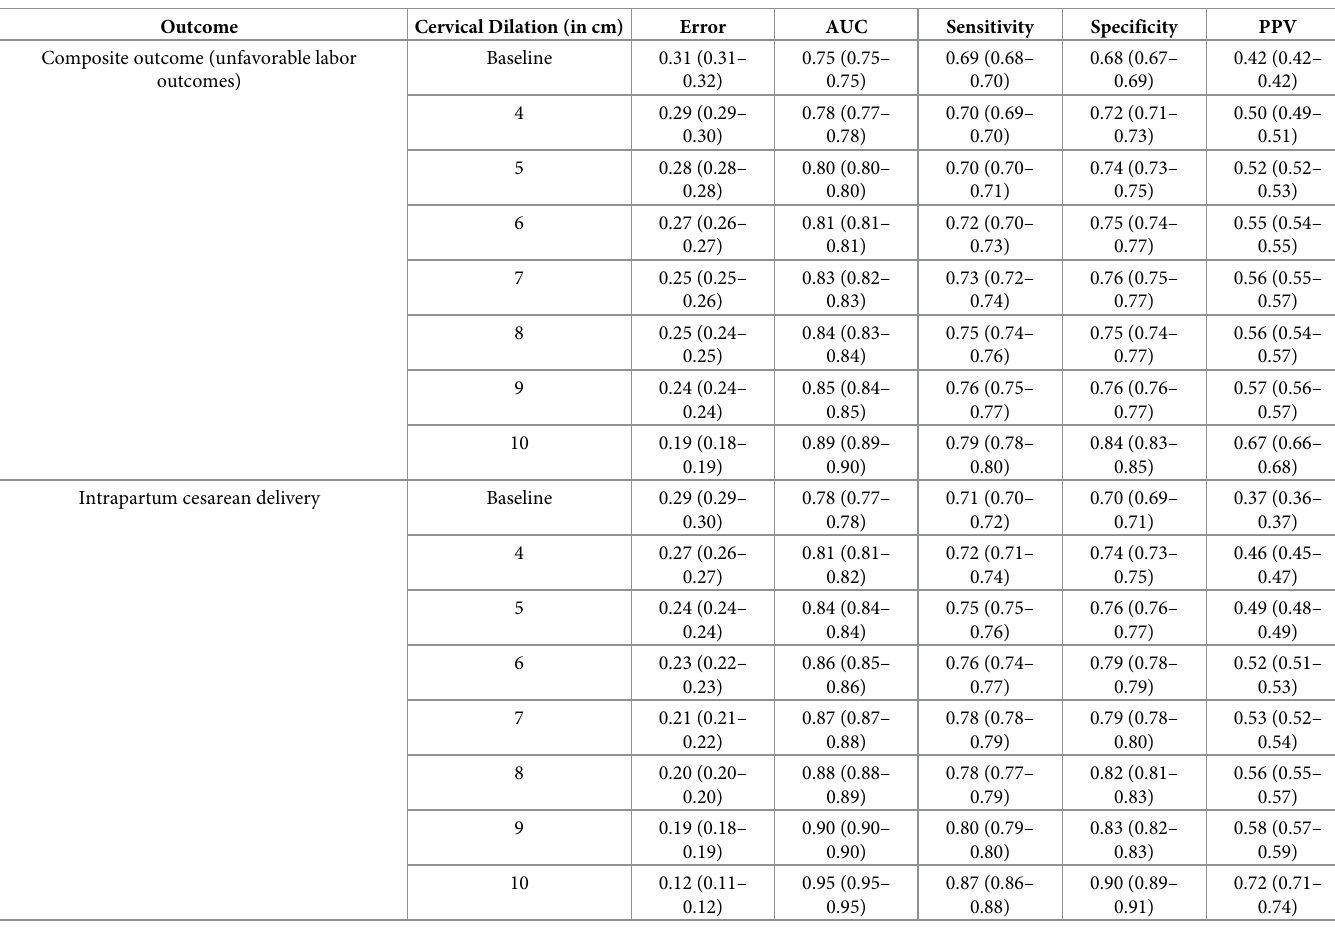
Table 2. Diagnostic performance of machine-learning–based prediction models of unfavorable labor outcomes and intrapartum cesarean delivery at first stage of labor a .